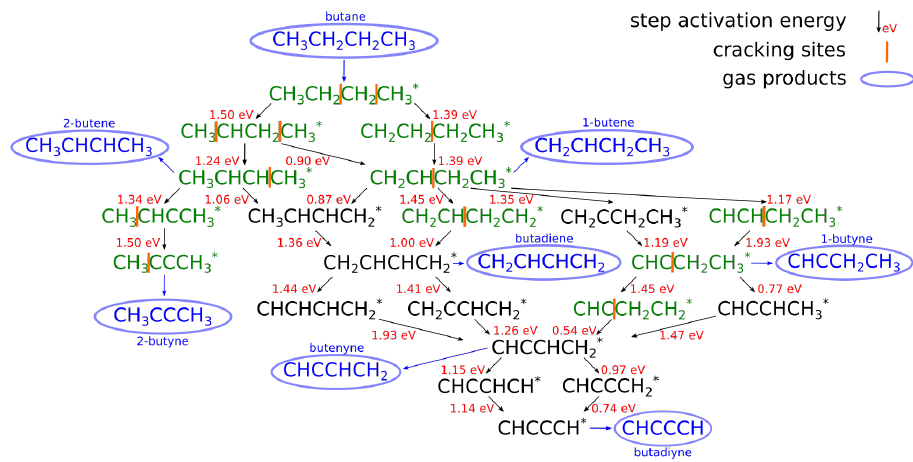
Figure 1. An example of the proposed reaction mechanism for the butane dehydrogenation over Cr 2 O 3 -type catalyst. The reaction activation energy is given for all elementary steps, while cracking sites are also depicted and their activation energies were also calculated via DFT. (Reprinted with permission from